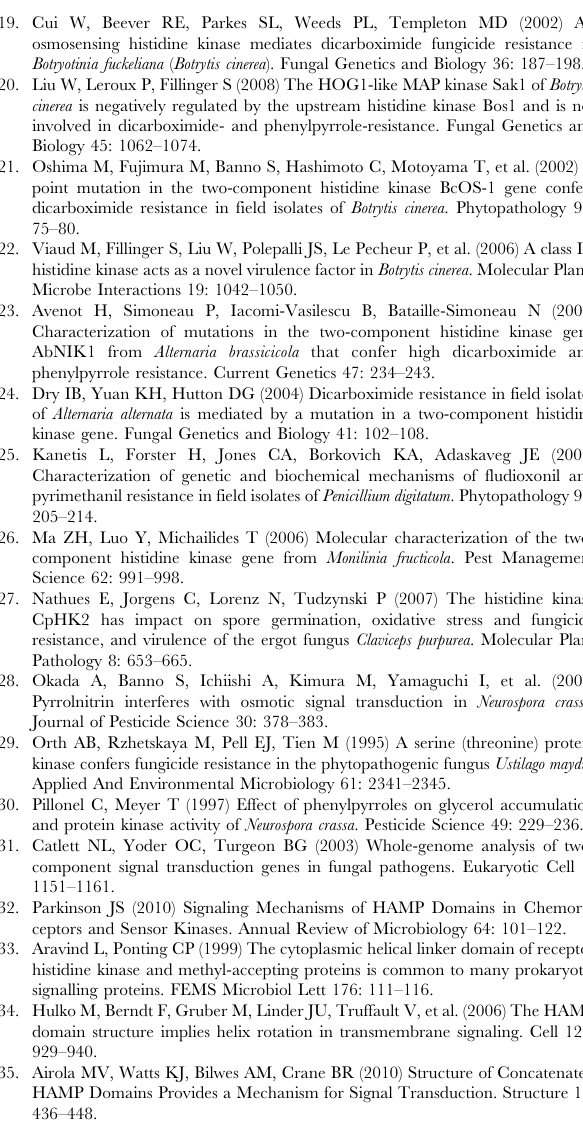
Figure S1 Predicted models for the HAMP domains of the histidine-kinase Bos1. (A) front, (B) back. Model predictions were performed on the Swiss-model server [45] by alignment to the crystal structure 3lnrA of the aerotaxis receptor Aer2 of Pseudomonas aeroginosa [35]. The orientation of the peptides is from up (N-terminus) to down (C-terminus). The side chains of amino acids located in helical regions (A) and in the connector (B) facing the neighbouring helices are presented.